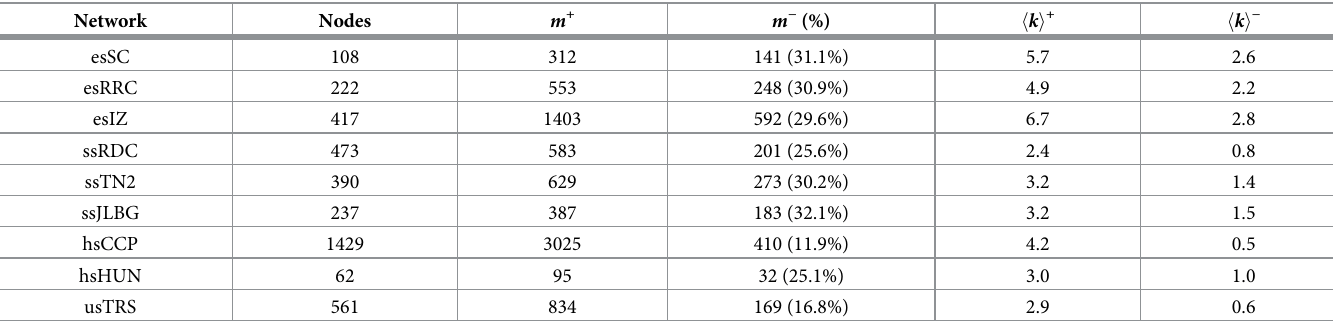
Table 2. Positive and negative links in the signed